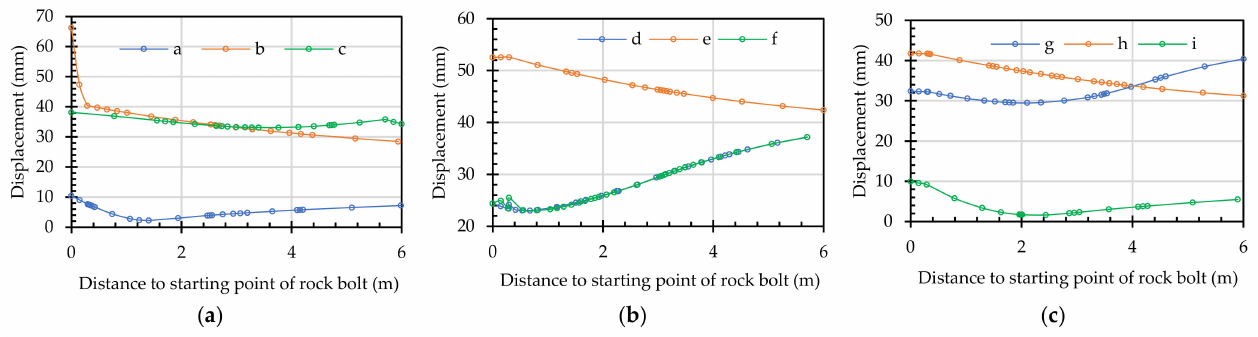
Figure 23. Displacement vs. location under unbiased pressure: ( a ) for rock bolts a, b, and c in the westbound tunnel; ( b ) for rock bolts d, e, and f in the MRT tunnel; and ( c ) for rock bolts g, h, and i in the eastbound tunnel.